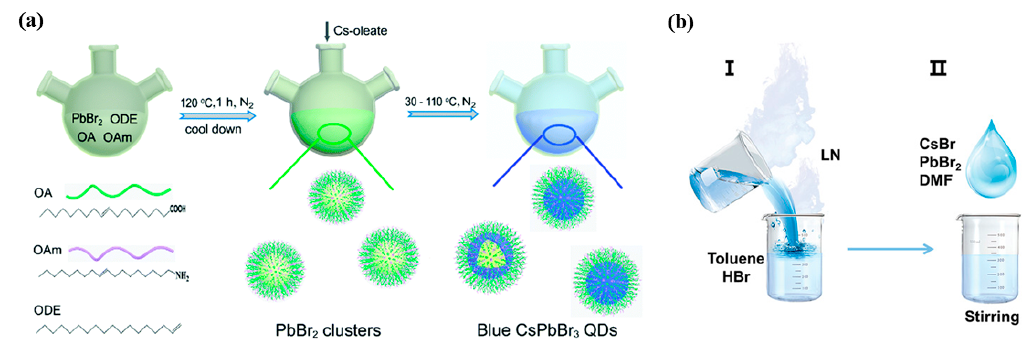
Figure 2. Schematic illustration of hot–injection (HI) method and ligand–assisted reprecipitation (LARP) method. ( a ) The typical synthesis process of PbBr 2 clusters and CsPbBr 3 QDs. Reproduced with permission from Ref. [11]. Copyright Royal Society of Chemistry, 2021. ( b ) LN–treated solution–processed CsPbBr 3 perovskites. Reproduced with permission from Ref. [18]. Copyright Wiley, 2021.